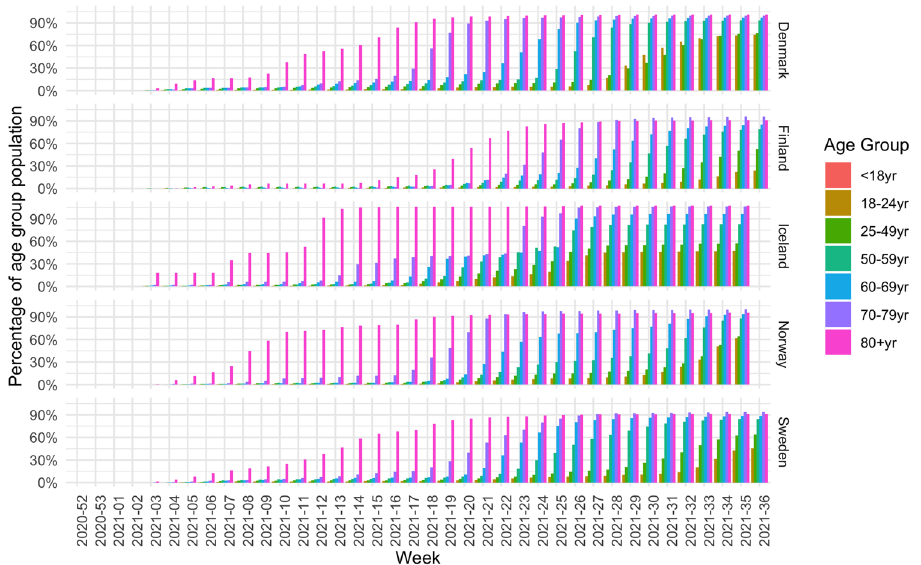
Figure 6. Fraction of population of each age group that has received the second vaccine dose or is fully